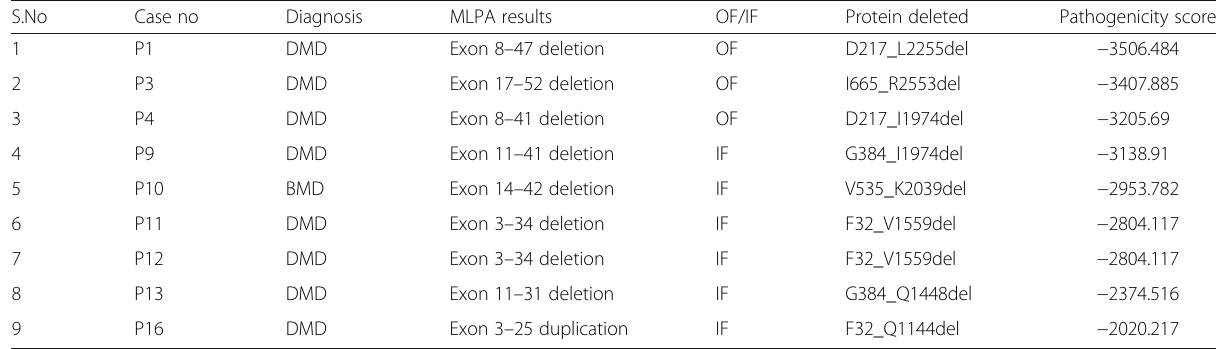
Table 1 MLPA results of Multiexon deletion (> 25) and missing amino acids with the predicted PROVEAN scores. IF/OF (In frame/ out of frame)